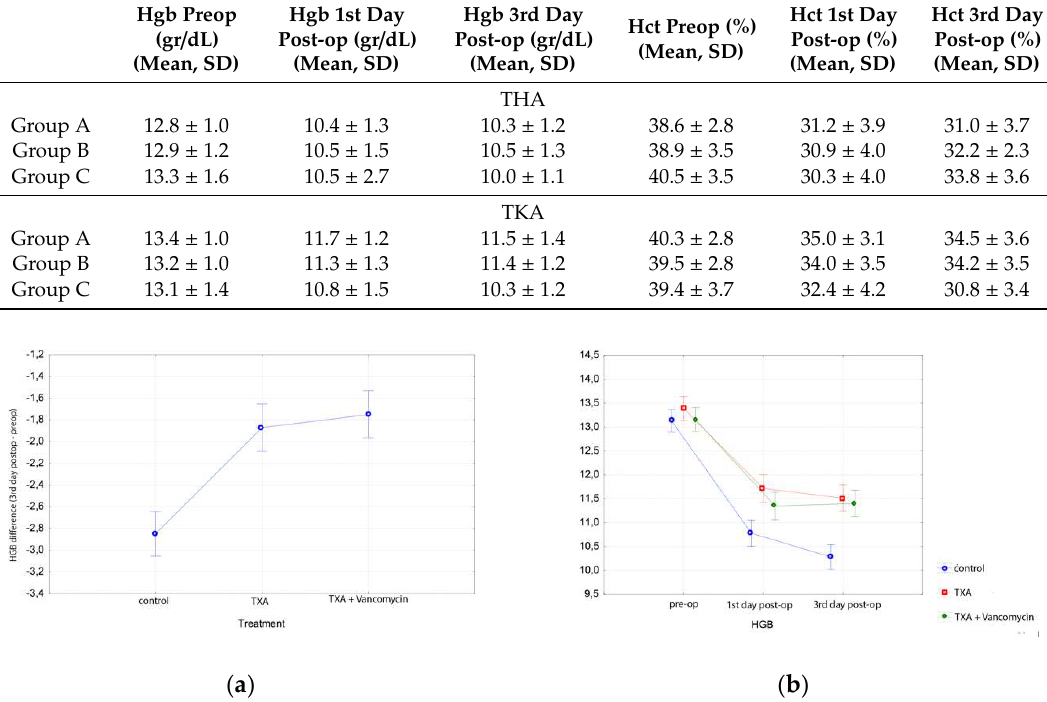
Figure 1. Results in total hip arthroplasty patients: ( a ) Hemoglobin di ff erence between preoperative and 3rd day postoperative value in the control and treatment groups of total hip arthroplasty; ( b ) Hemoglobin levels before total hip arthroplasty, at the first and third postoperative days in the control and treatment groups.